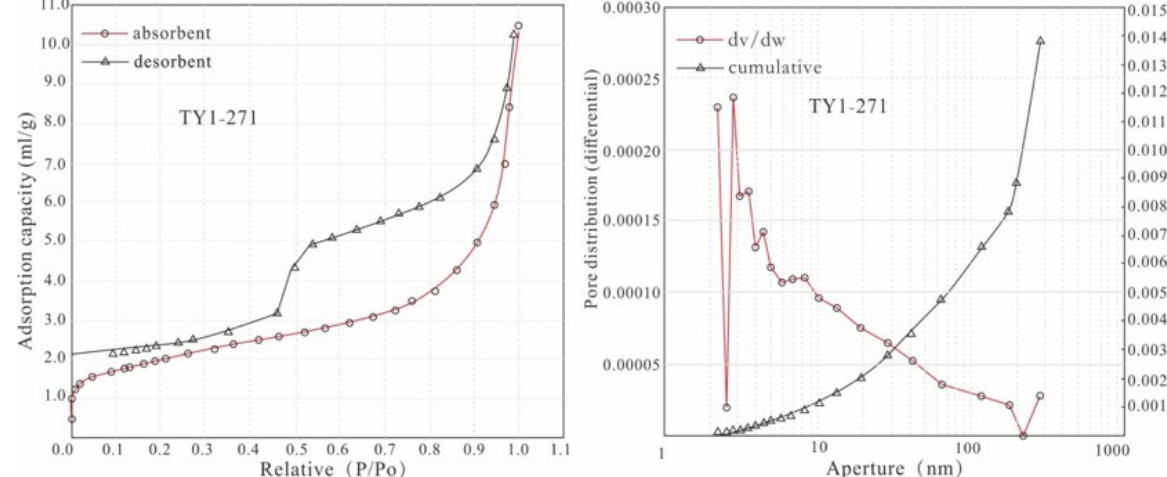
Figure 7. The nitrogen adsorption and desorption curves of the Galedesi Formation shale. Table 3. Data of the pore volume distribution measured using the nitrogen adsorption method.